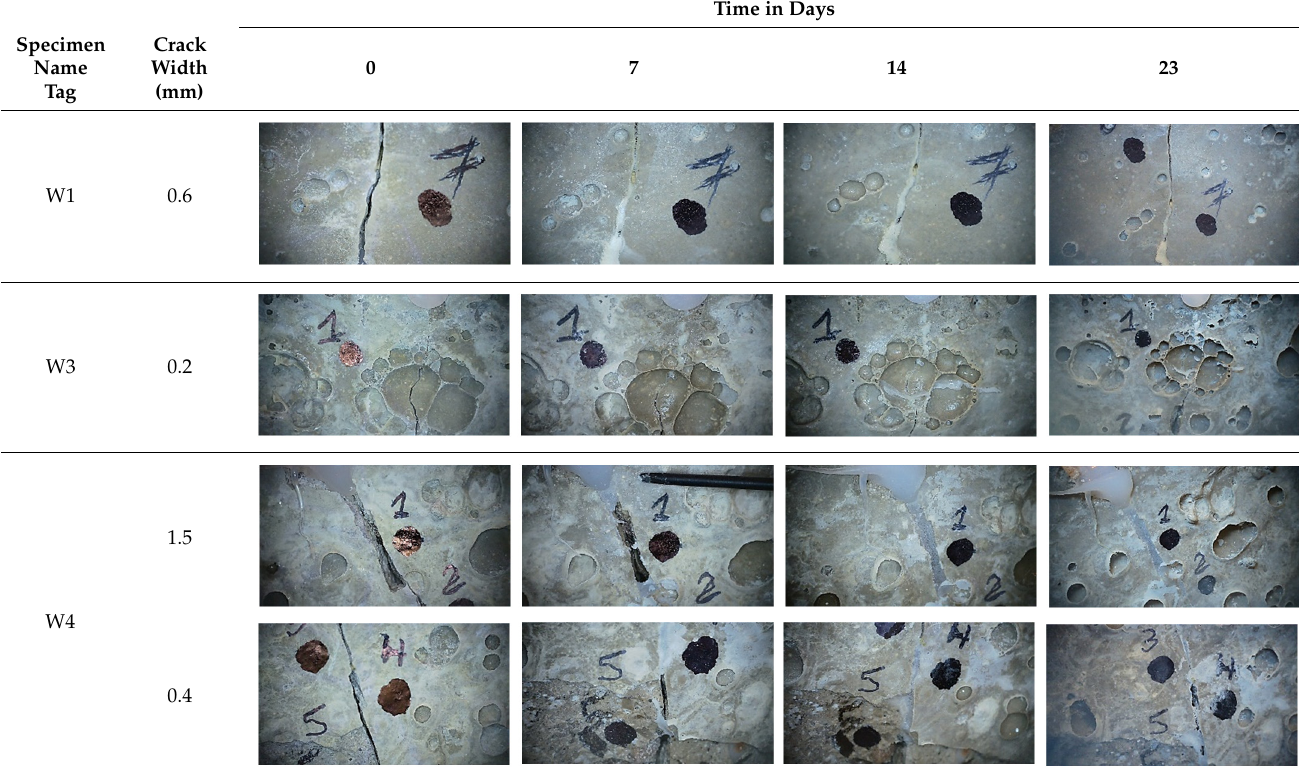
Table 15. Image compilation for self-healing evaluation for intrinsic approach. Time in Days